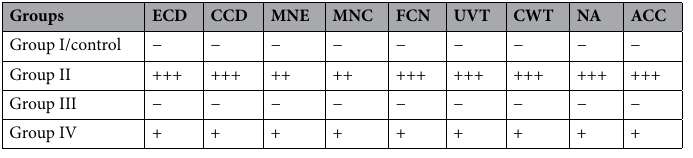
Table 2. Alleviation of NaCl-induced root anatomical damages by external COR